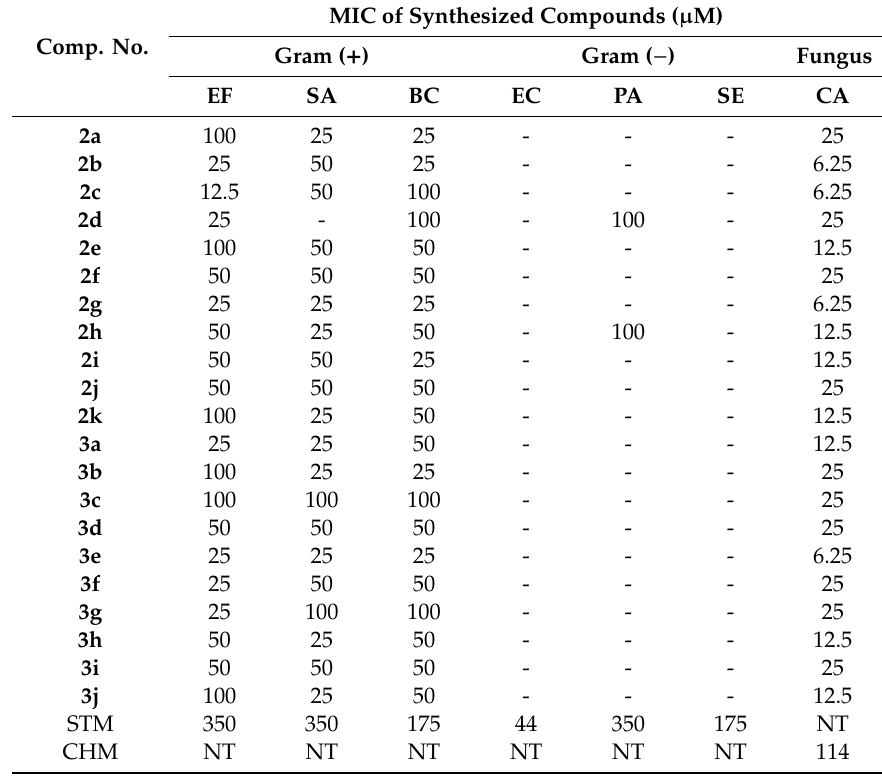
Table 2. Minimum inhibitory concentration (MIC) of synthesized thiosemicarbazones 2a – k and 3a – j .